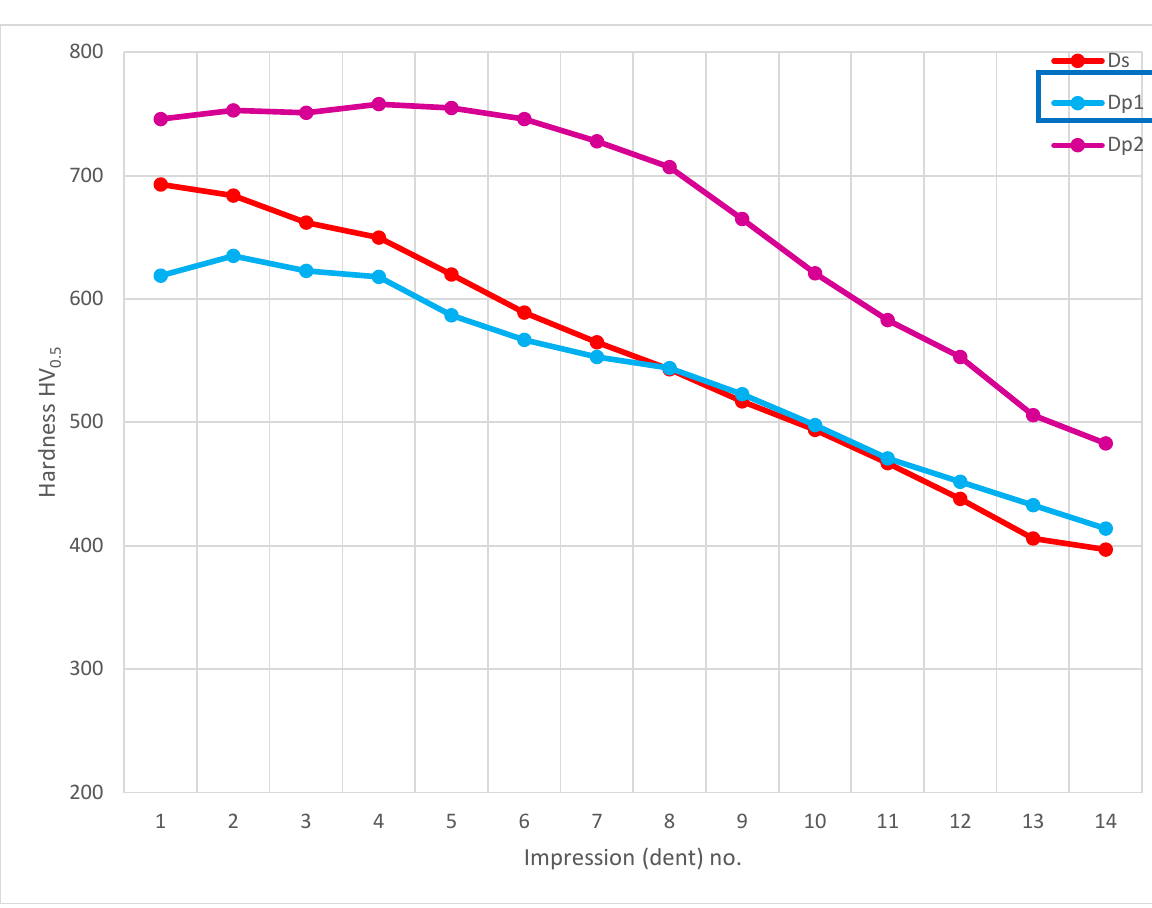
Figure 22. Microhardness measurement results. Cross-section H-H.